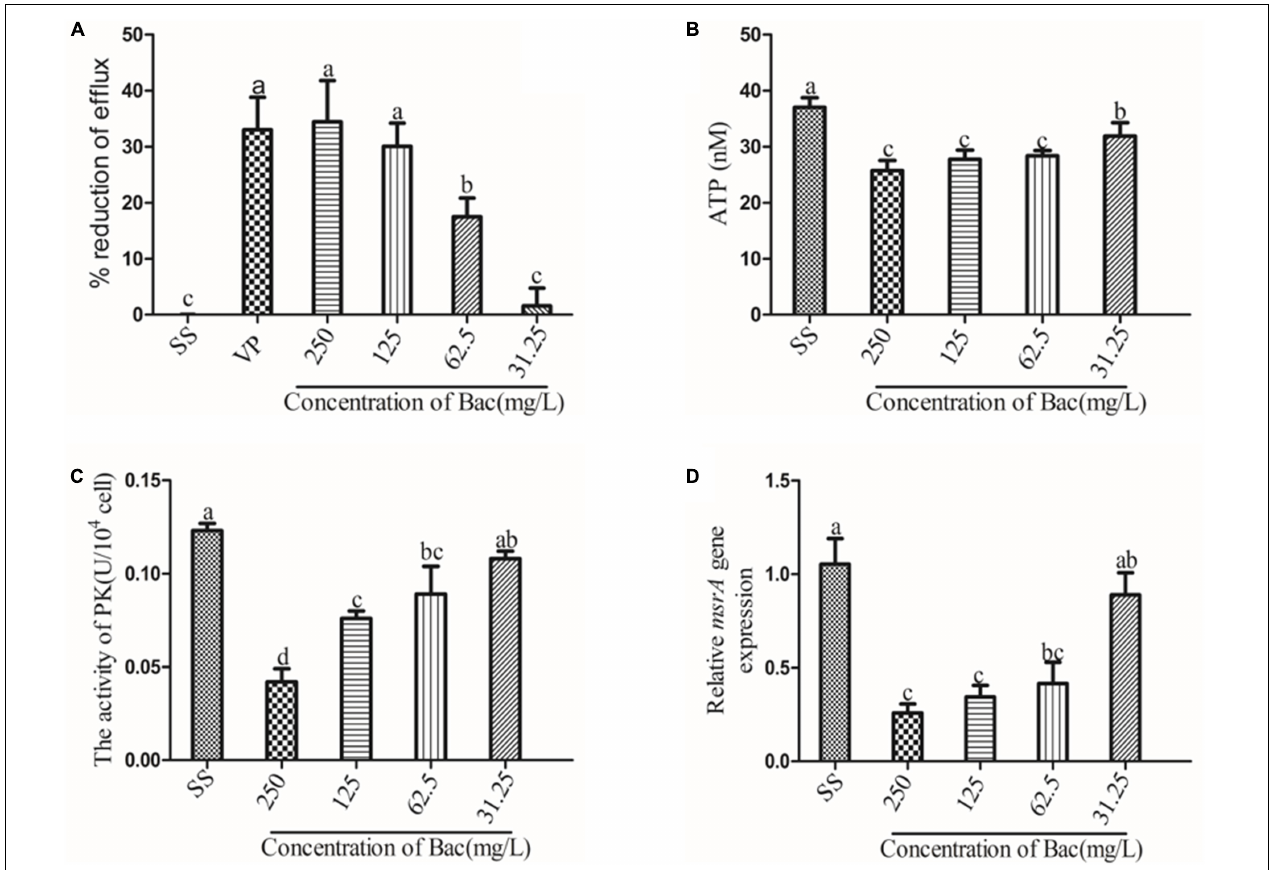
FIGURE 3 | Baicalin-mediated ARSS efflux. (A) Baicalin and positive control verapamil inhibited the efflux of EtBr in ARSS. (B) Baicalin influenced the ATP content. (C) Baicalin influenced the activity of PK. (D) Baicalin influenced the transcription level of the msrA gene. Bars in the same index without the same letters differ significantly ( p <